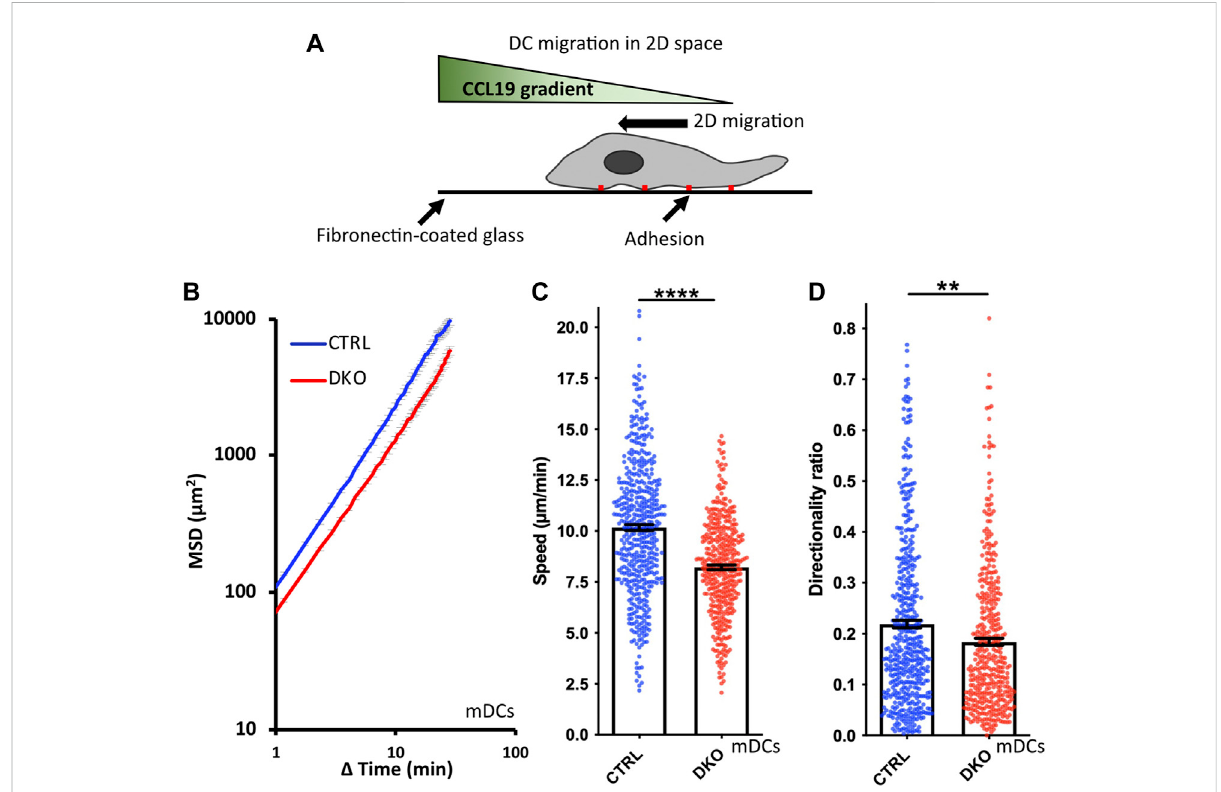
FIGURE 3 LossofEvlandVASPimpairsDCchemotaxisin2D. (A) Illustrationofexperimentalsetup. (B – D) MaturecontrolandDKODCswereseededintoa migration chamber. DCs were allowed to migrate for 6 h towards the chemokine CCL19. Their migratory behavior was evaluated based on bright- fi eld images obtained at 35 s intervals. (B) Quanti fi cation of Mean Squared Displacement (MSD). Speed (C) and directionality (D) are depicted as mean ± SEM (N (control) = 493 and N (DKO)= 420 cells from 3 independent experiments; statistical analysis by Mann-Whitney test; ** p < 0.01; **** p < 0.0001; ns = non signi fi